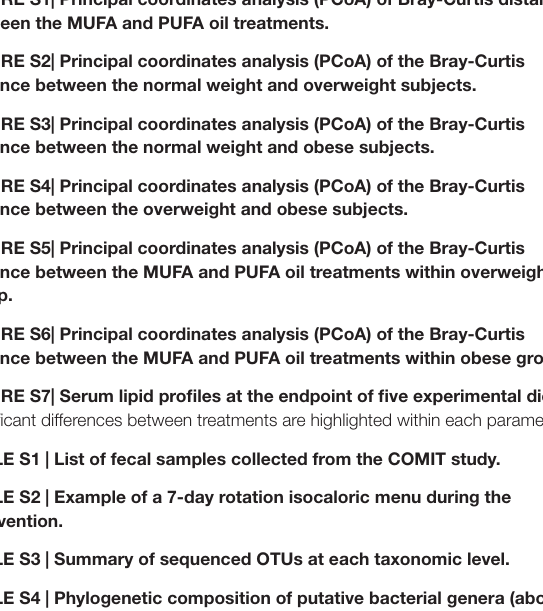
TABLE S5 | List of bacterial genera in low abundance (below 0.1% of community). TABLE S6 | Correlation between bacterial phyla and metabolic